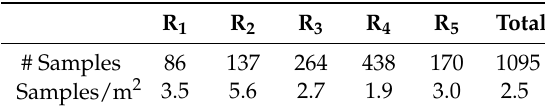
Table 1. Number of gathered fingerprints inside the scenario (431.8 m 2